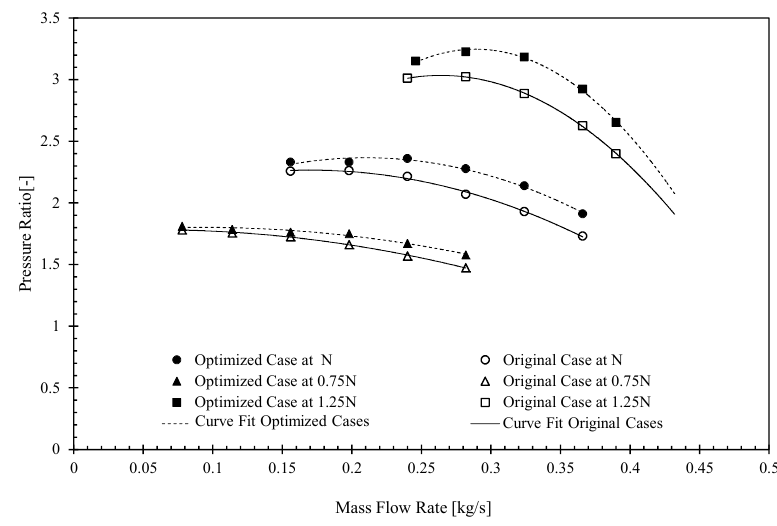
Figure 18. Pressure ratio vs. mass flow rate for original and optimized case.